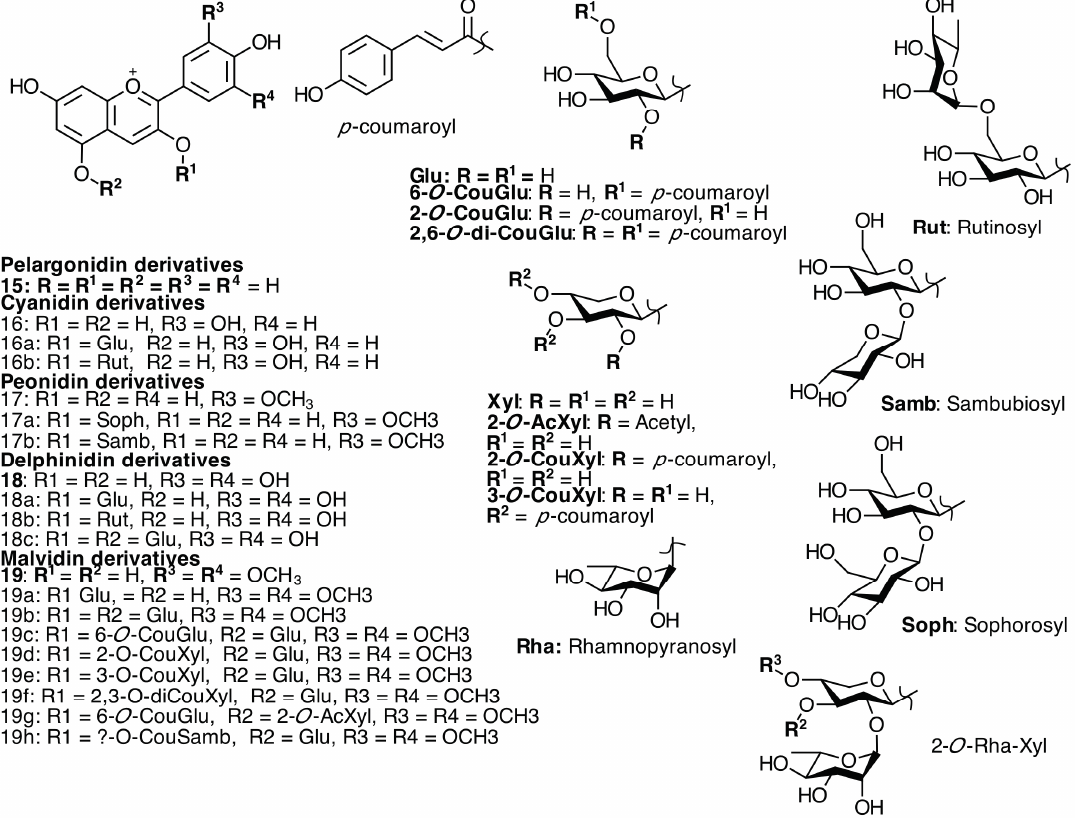
Figure 4. Anthocyanins and anthocyanidins isolated from Melastomataceae species. Five known flavonol glycosides were also identified from Monochaetum multiflorum (Bonpl.) Naudin by comparison of their UV-vis and 1 H-NMR spectra with those reported in the literature as